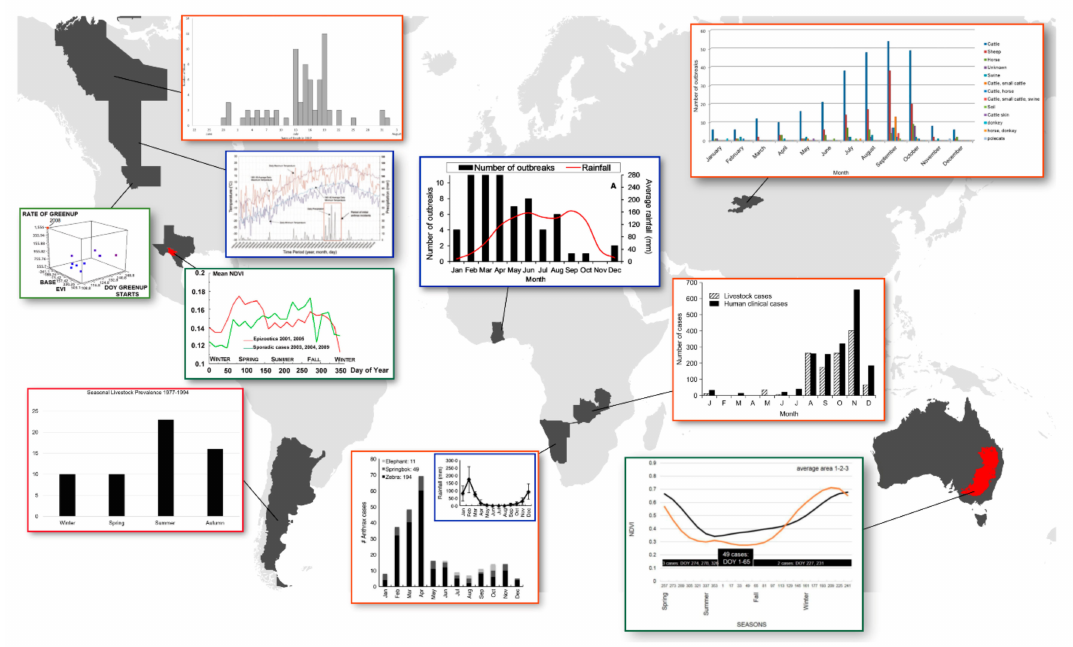
Figure 1. Seasonality of anthrax outbreaks is a global phenomenon. Here we illustrate clear patterns of outbreak intensity and timing associated with month (orange bounding boxes; Kyrgyzstan [6]; Northwest Territories, Canada [7]; Zambia [8]), season (red bounding box; Argentina [9]), precipitation (blue bounding boxes; Alberta, Canada [10], Ghana [11], Etosha National Park, Namibia [12]), enhanced vegetation index (green bounding box; EVI; Montana, Blackburn & Goodin, unpublished data), and normalized di ff erence vegetation index (dark green bounding boxes; NDVI; Australia [13] and Texas [14]). Red areas in Texas and Australia are the recently defined enzootic zone [15] and re-defined anthrax belt [16],